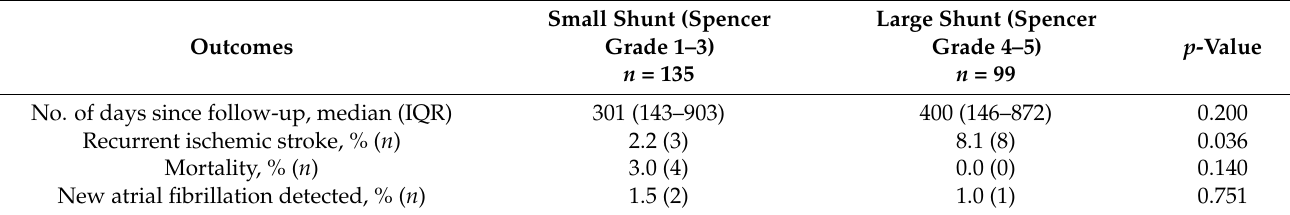
Table 2. Long-term outcomes of PFO patients with small and large shunt.